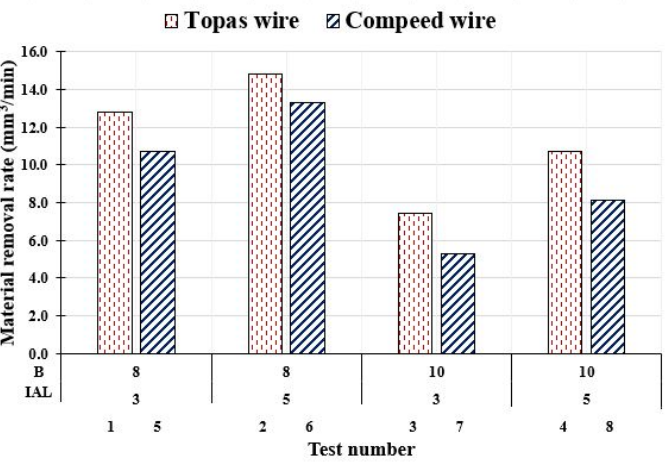
Figure 4. Material removal rate in each test for the Topas and Compeed wire electrodes.